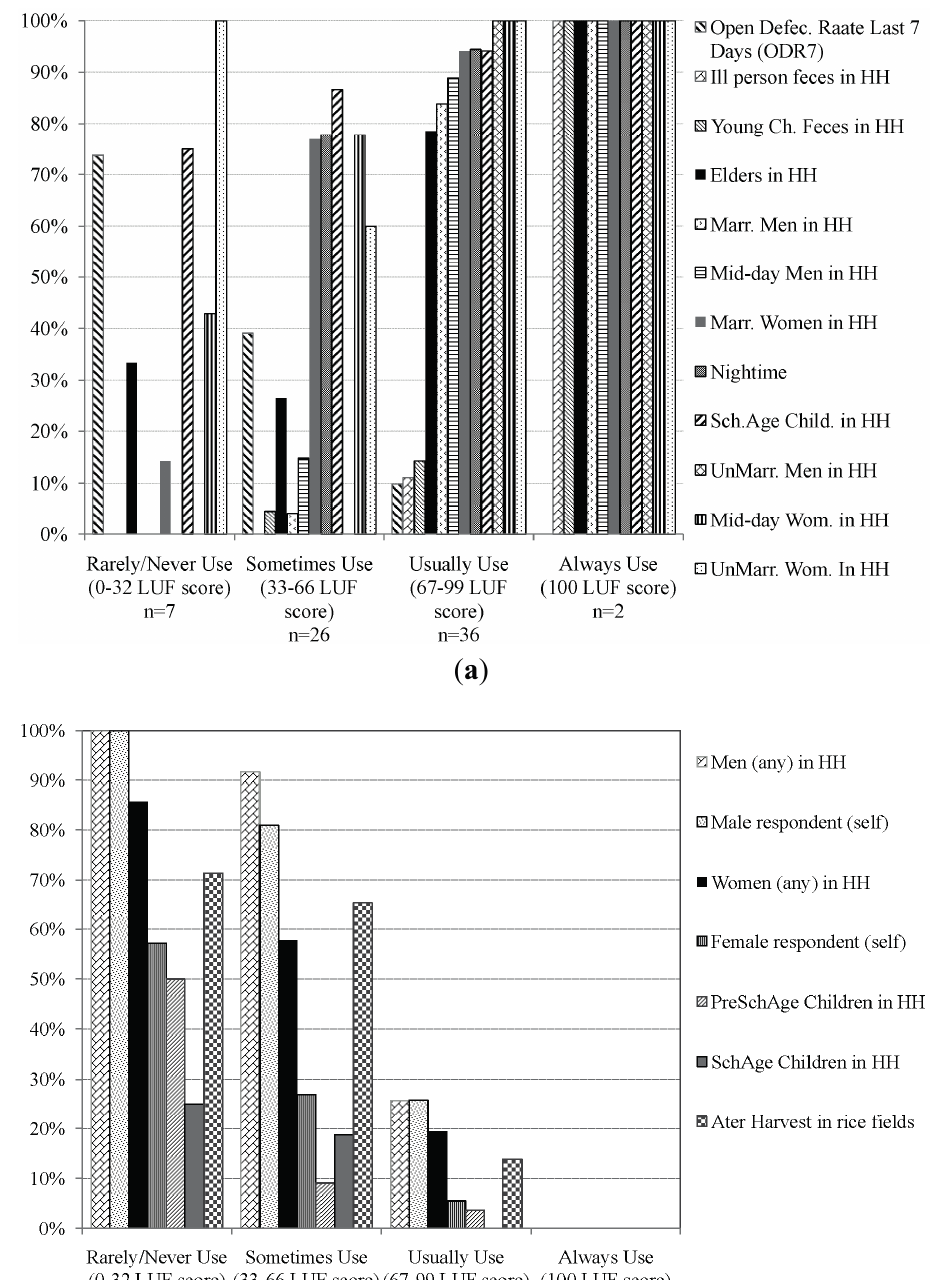
Figure 3. Intra-household and temporal variations in defecation behavior of study households with a functional latrine (n = 71), grouped by their LUF level (F1 data). ( a ) Frequency of “always use latrine” for each LUF item and average ODR7 score; ( b ) Portion reporting open defecation on “some”, “most” or “every” day of the last 7 days for each ODR7